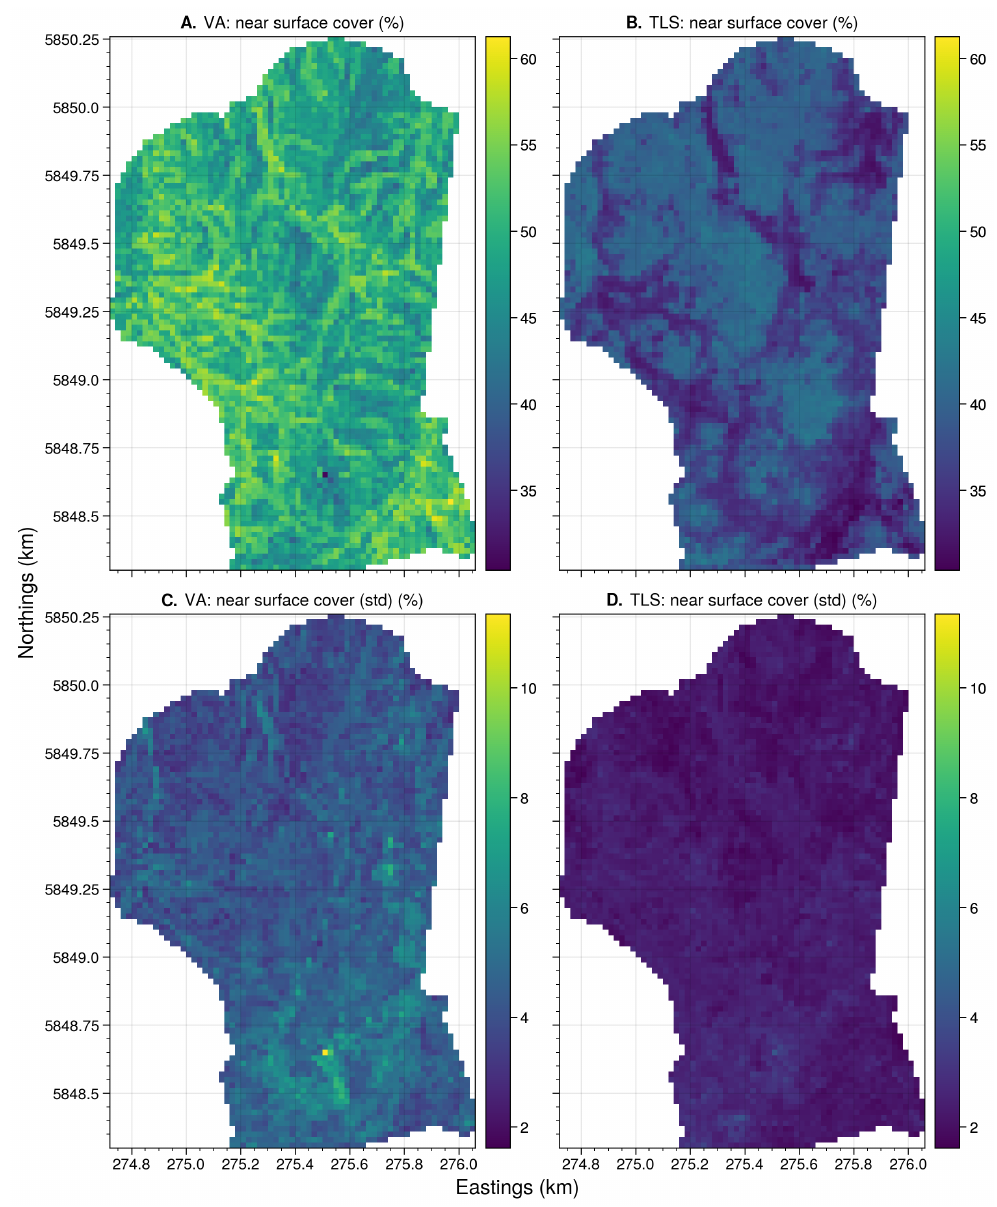
Figure A4. The mean and standard deviation of landscape-level predictions for near-surface fuel cover using visual assessments ( A , C ) and TLS ( B , D ) at